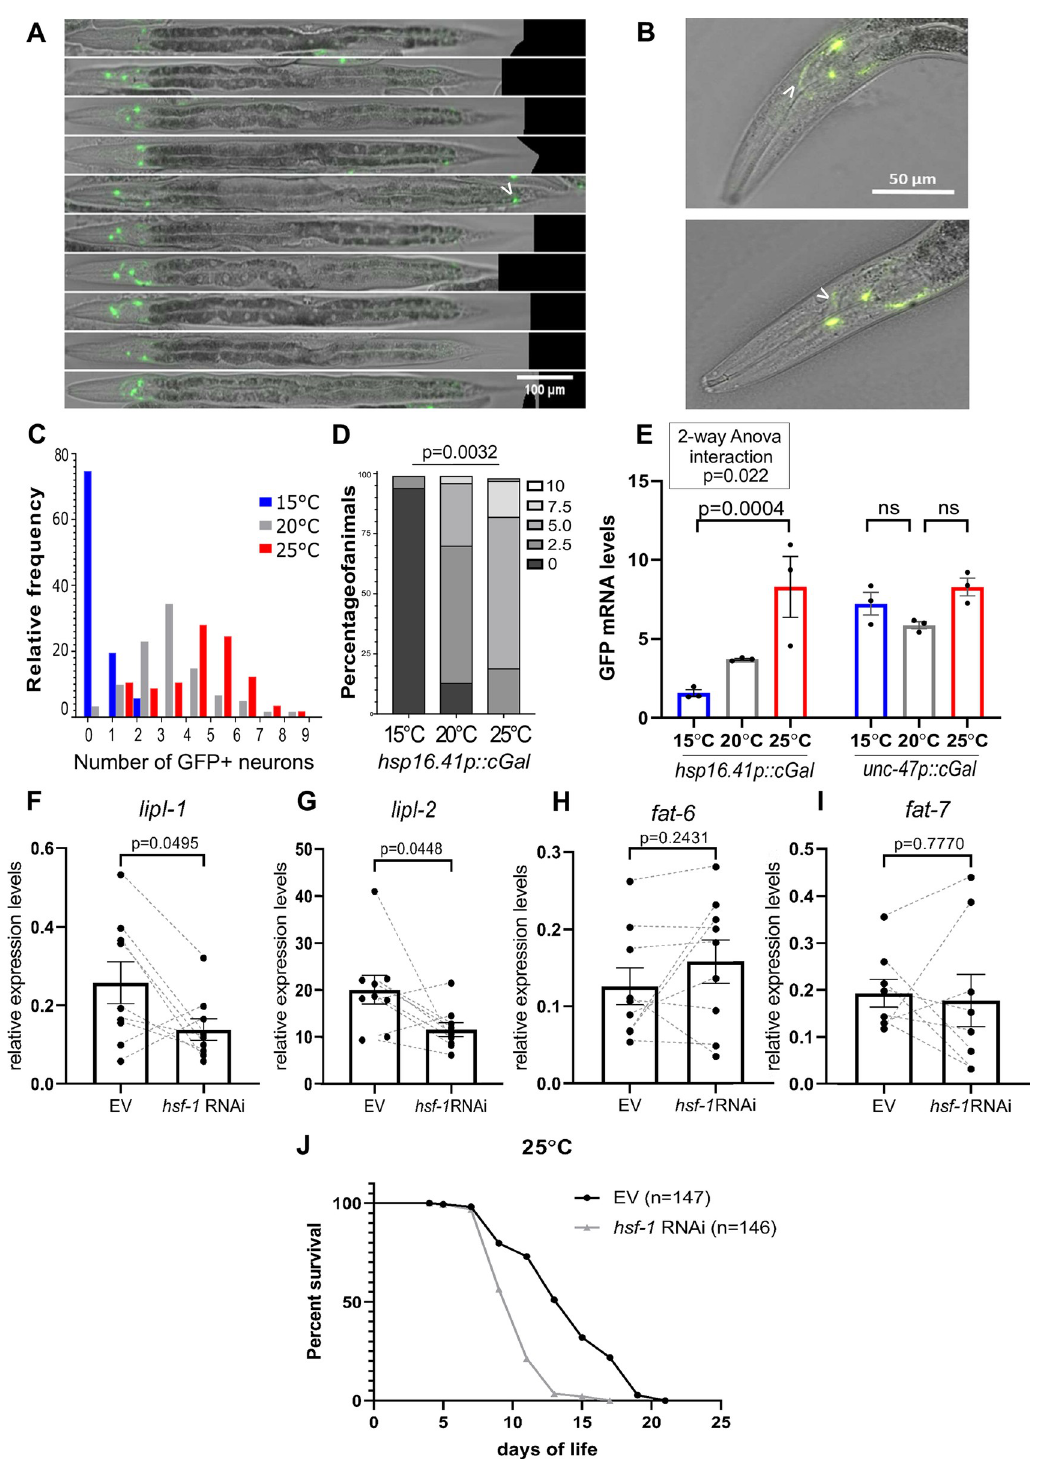
Fig 6. Evidence for an HSF-1–dependent thermostat in WT animals. (A, B) The figures show representative images taken at 20 × magnification with both GFP fluorescence and Nomarski optics of young adult hsp16 . 41p :cGAL/UAS:GFP (PS7171) animals raised at 20˚C. In the absence of stress, GFP is expressed exclusively in anterior cells and occasionally in tail neurons (arrowhead in A). The cells are neurons as they show axonal projections (in B, arrowhead points at a visible axonal projection). Animals shown were straightened using the Worm-align FIJI-based pipeline [53]. Scale bar: 100 μ m (A), 50 μ m (B). (C)